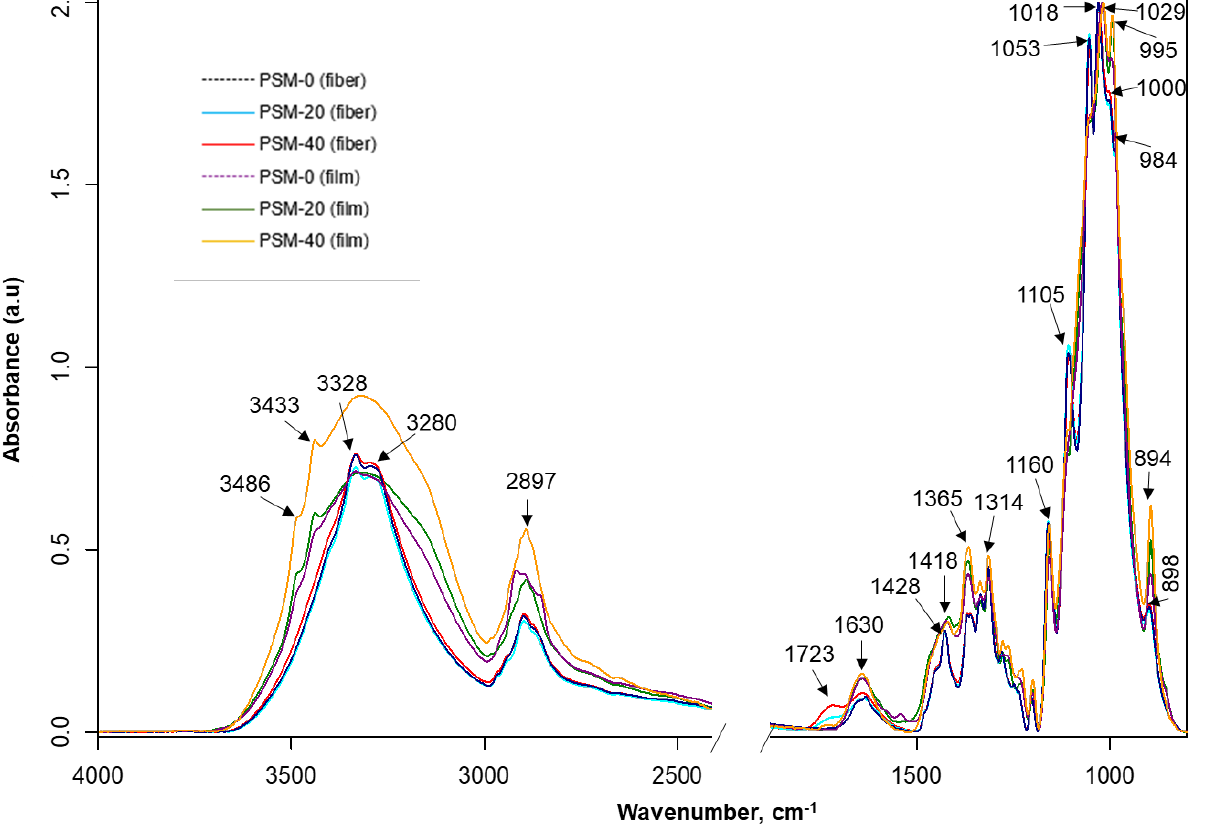
Figure 6. FTIR analysis of plasma surface modified cotton fibers and their corresponding regenerated films. FTIR spectra of control (PSM-0) and oxygen plasma surface modified (PSM-20 and PSM-40) cotton fibers and regenerated cellulose films prepared from control and PSM cotton fibers.